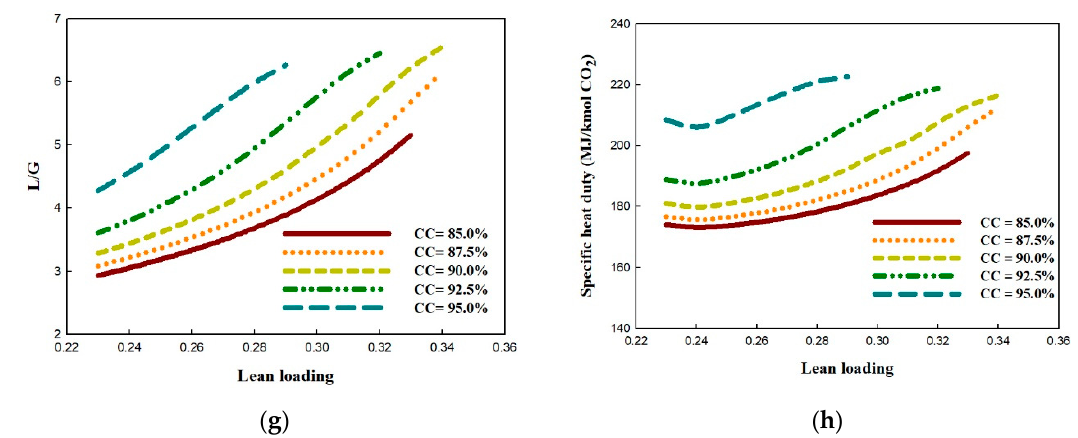
Figure 2. Optimal solutions for the operations for flue gas conditions (flow rate, CO 2 concentration, and temperature) and capture efficiency changes under different lean loading of solvent in terms of L/G and specific reboiler duty. ( a ) L/G-flue gas flowrate change; ( b ) specific heat duty-flue gas flowrate change; ( c ) L/G-flue gas concentration change; ( d ) specific heat duty-flue gas concentration change; ( e ) L/G-flue gas temperature change; ( f ) specific heat duty-flue gas temperature change; ( g ) L/G-capture efficiency change; ( h ) specific heat duty-capture efficiency change.